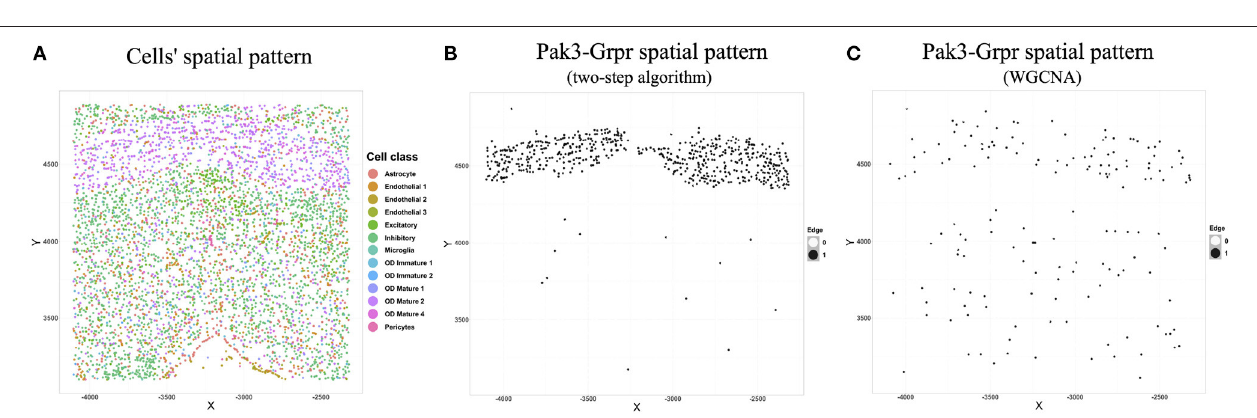
FIGURE 5 | (A) Cells’ spatial distribution pattern, where different colors of points correspond to different cell classes. (B) The spatial pattern of the Pak3-Crpr connection obtained by two-step algorithm. The black point reflects that an edge exists between “Pak3” and “Crpr” in that cell. (C) The spatial pattern of the Pak3-Crpr connection obtained by